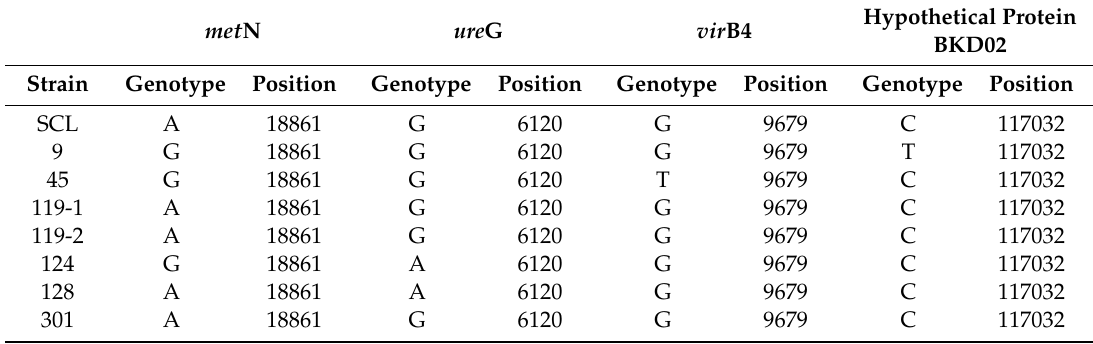
Table 4. Genotypes of the identified SNPs among Chilean B. canis isolates with the SCL